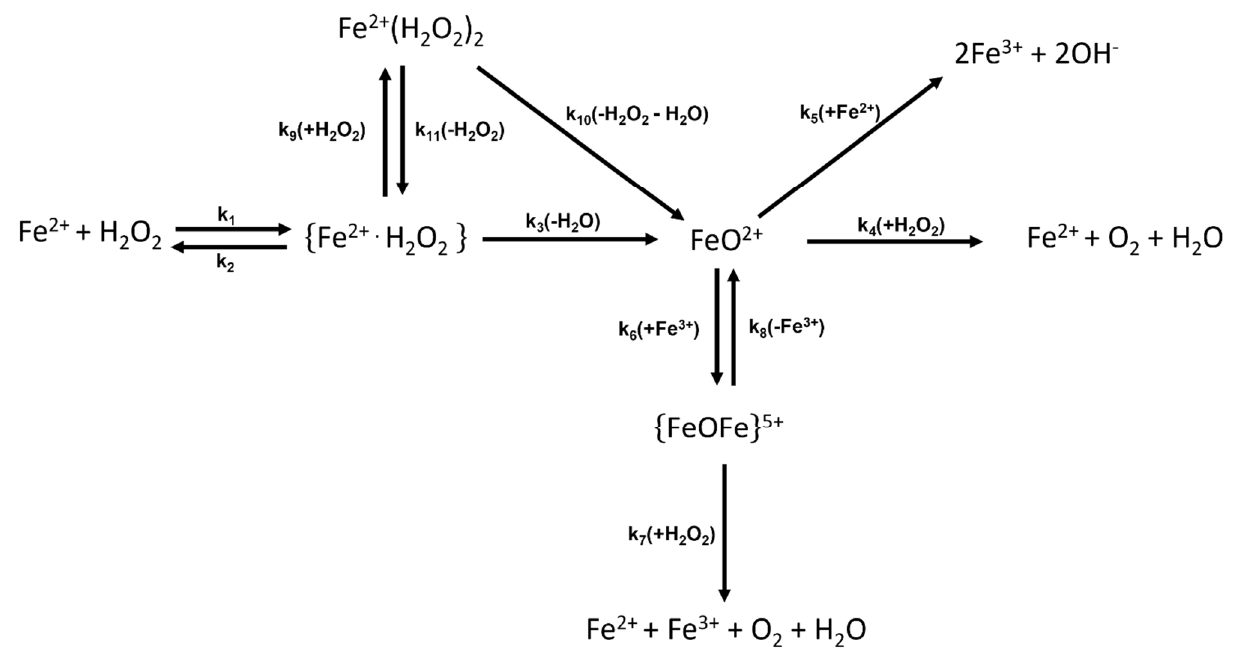
Figure 1. The nonradical mechanism.